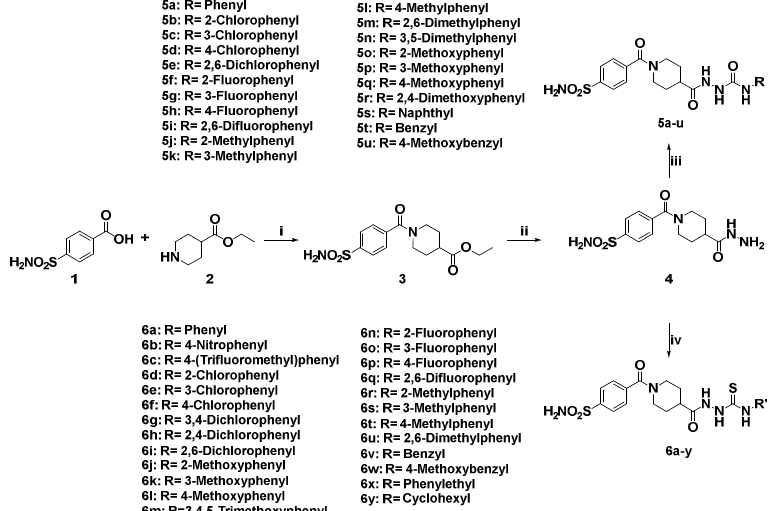
Scheme 1. General synthetic procedure for sulfonamides subsets 5a – u and 6a – y . Reagents and condi- tions: (i) EDCI, HOBt, dry CH 3 CN r.t. 12 h, yield 77%; (ii) NH 2 NH 2 ·H 2 O, absolute EtOH, reflux 3 h, yield